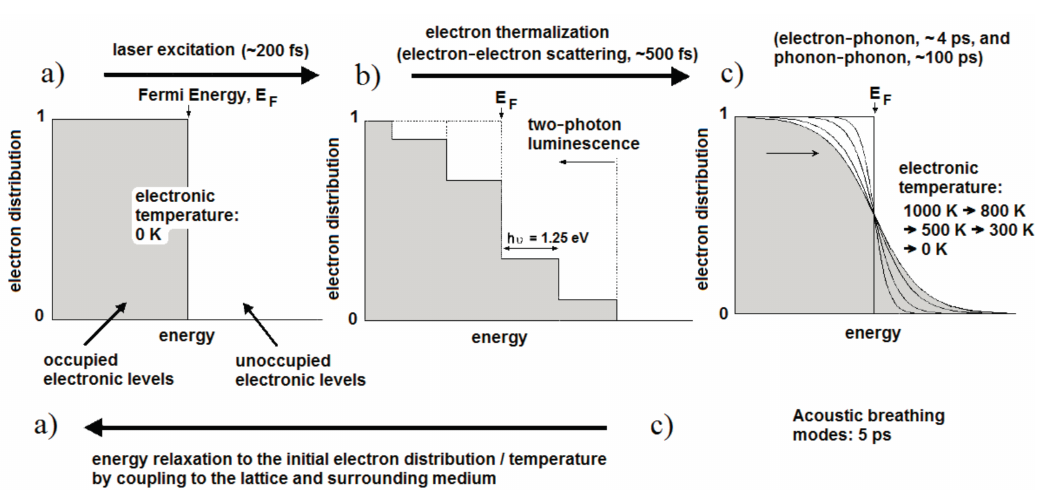
Figure 1. Electron distributions and corresponding timescales of the fundamental processes in laser heating of Au NPs: the initial distribution ( a ) is excited to a non-thermal state ( b ); before relaxing to the Fermi-Dirac distribution ( c ) and finally returning to the initial state once energy has been transferred to the surrounding medium (after Link and El-Sayed